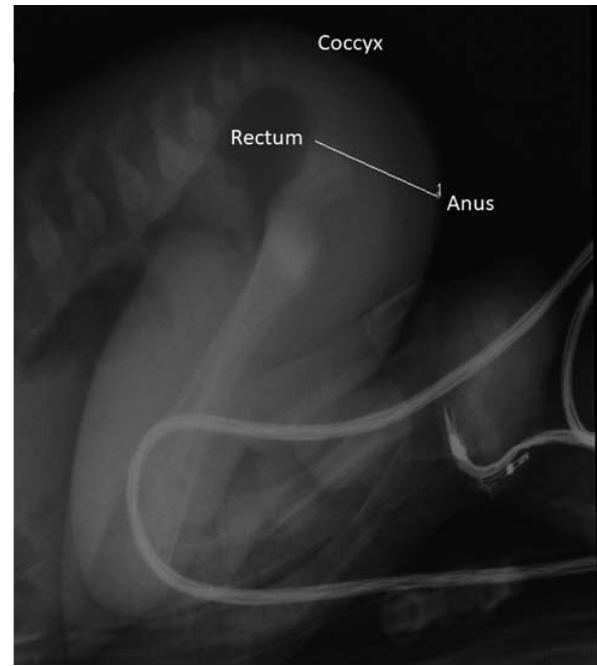
Fig. 1 Distal colostogram demonstrating anatomy of anorectal malformation.